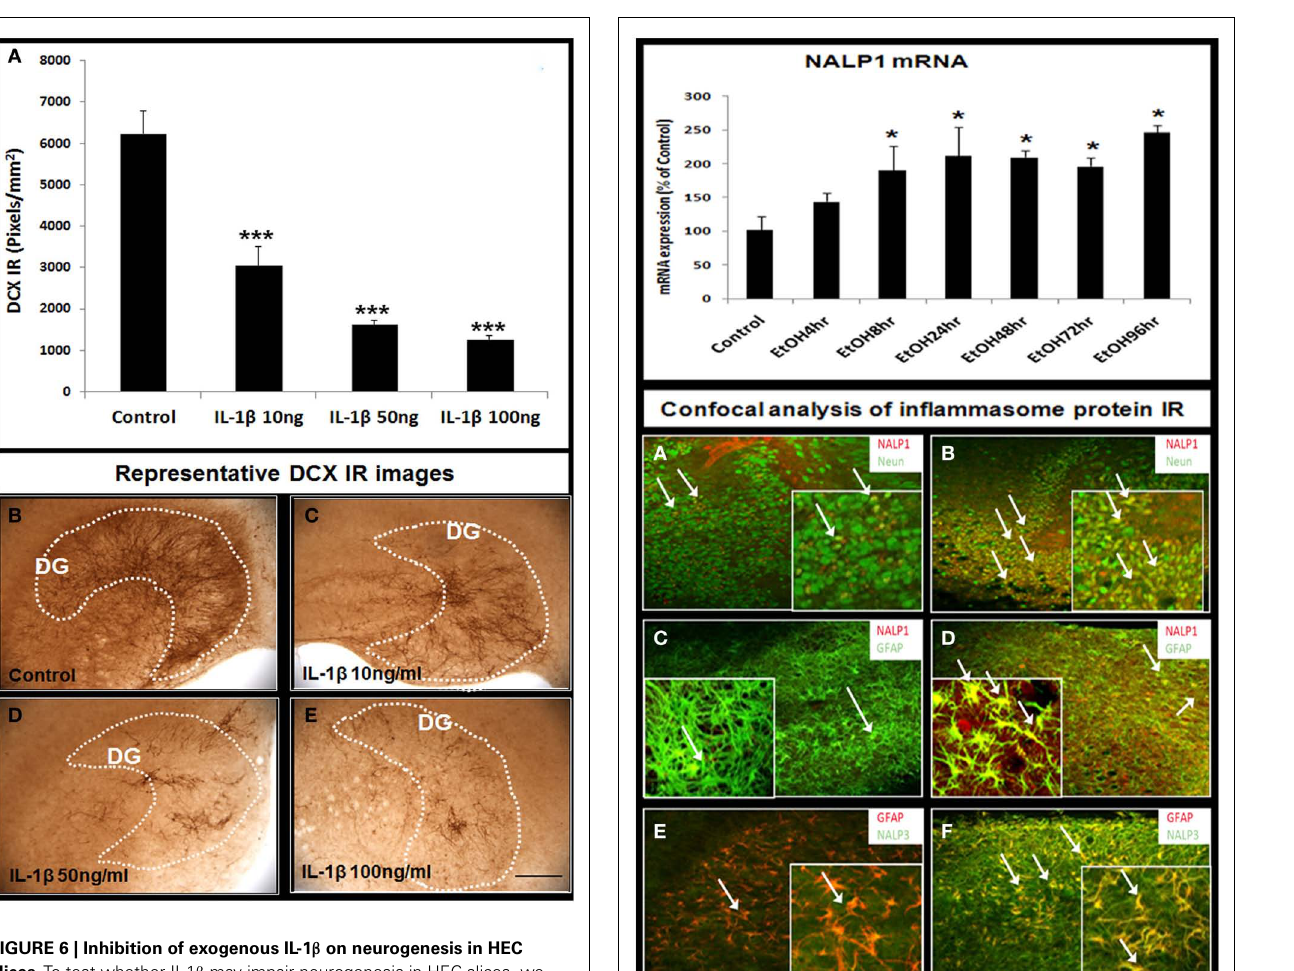
FIGURE 6 | Inhibition of exogenous IL-1 β on neurogenesis in HEC slices. To test whether IL-1 β may impair neurogenesis in HEC slices, we treated slices at 10 DIV with exogenous IL-1 β (10, 50, and 100ng/ml) for 4days and then DCX IR was determined. Bar graph (A) indicates IL-1 β dose-dependently inhibited neurogenesis as indicated by significant reduction of DCX + IR. Data represent mean ± SEM. ANOVA F (3, 23) = 7.301, p < 0.0001, and Fisher post hoc : *** p < 0.001 compared with control, n = 6–8.The experiments were repeated with similar designs and results. Representative images of DCX + IR from control and IL-1 β -treated slices were shown in (B–E) (scale bar = 200 μ m). alsoincreasedinpostmortemalcoholicbrainrelativetocontrolsby in postmortem alcoholic brain compared to controls (Control vs.